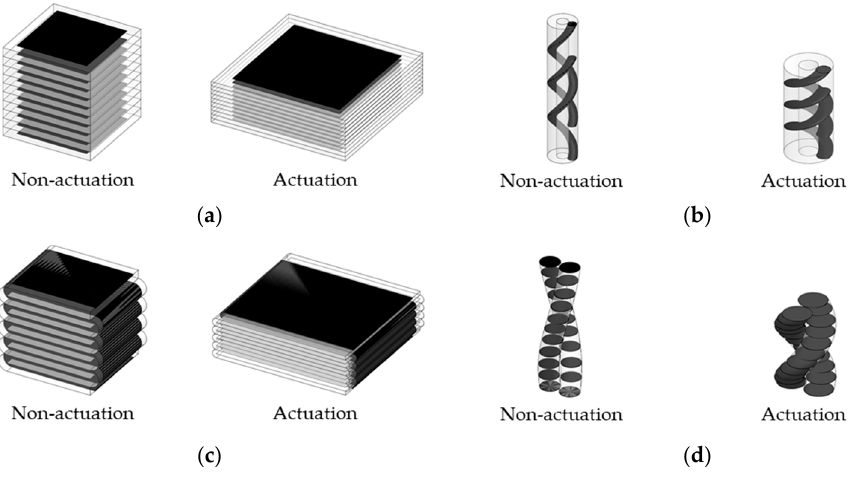
Figure 5. Schematics of Linear Contraction DEA. Transparent: Elastomers, Black: Electrodes ( a ) Multi-stack actuator; ( b ) Helical actuator; ( c ) Folded actuator; ( d ) Twisted actuator.